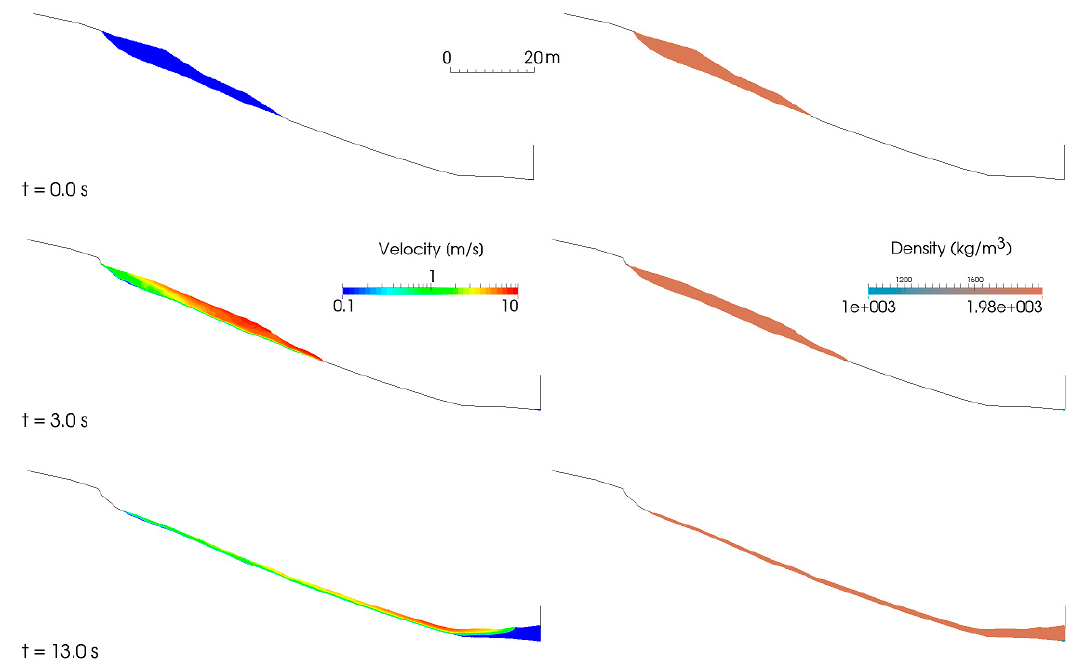
Figure 4. Representative frames of landslide run-out and impact. Contour plots show velocity magnitude (left-hand panels) and density field.